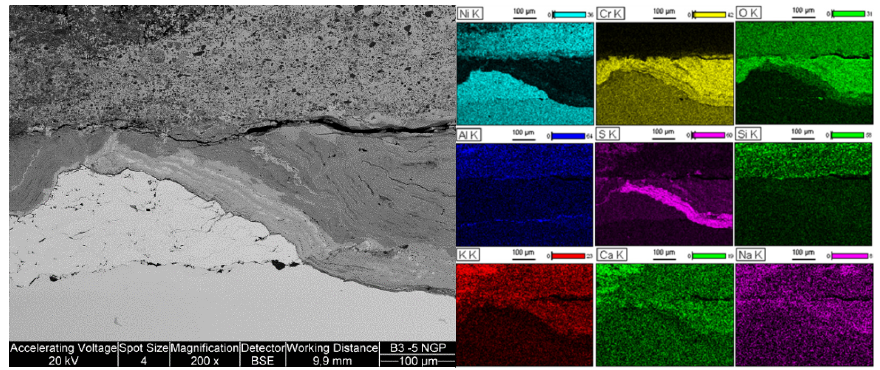
Figure 10. SEM (BSE) image of the remains of the IN625 coating and EDX map analysis from the windward side.